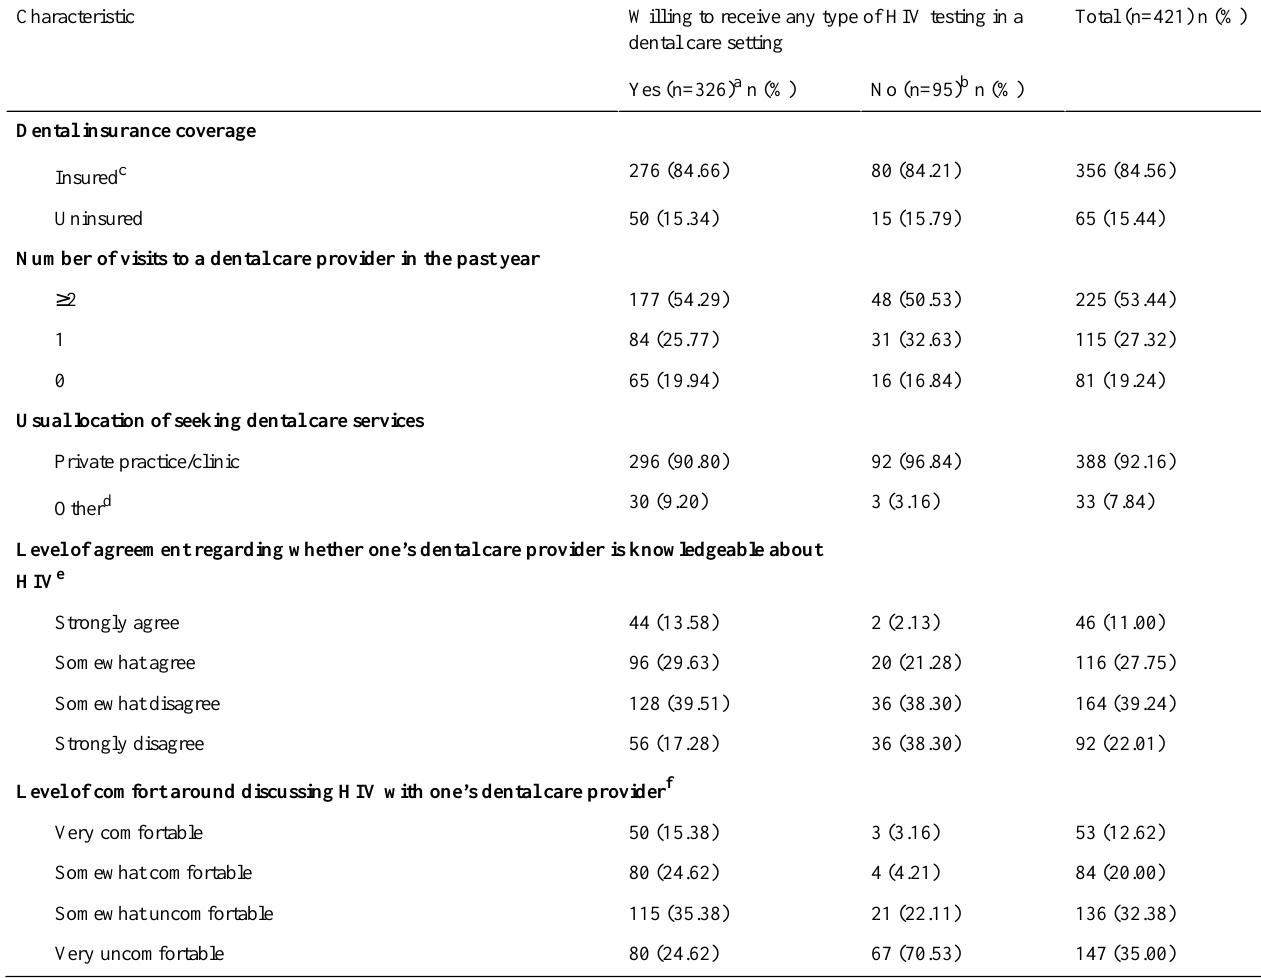
Table 2. Use of and experiences with seeking dental care services among study participants, United States, December 2018 to February